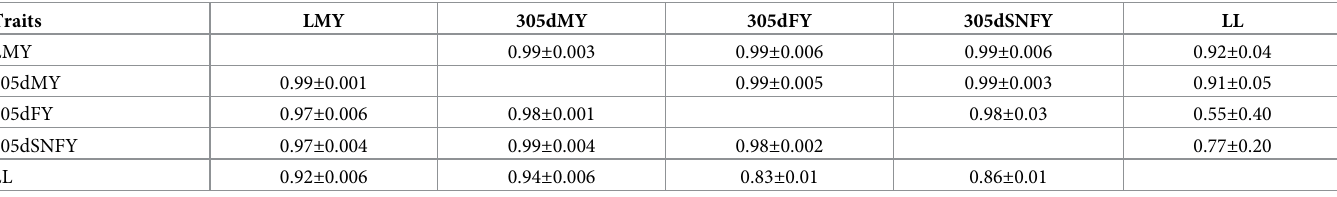
Table 6. The posterior means of genetic correlations with posterior standard deviation (PSD) of whole lactation (above diagonal) and first lactation (below the diag- onal) for production traits using a two-trait model for Sahiwal cattle.